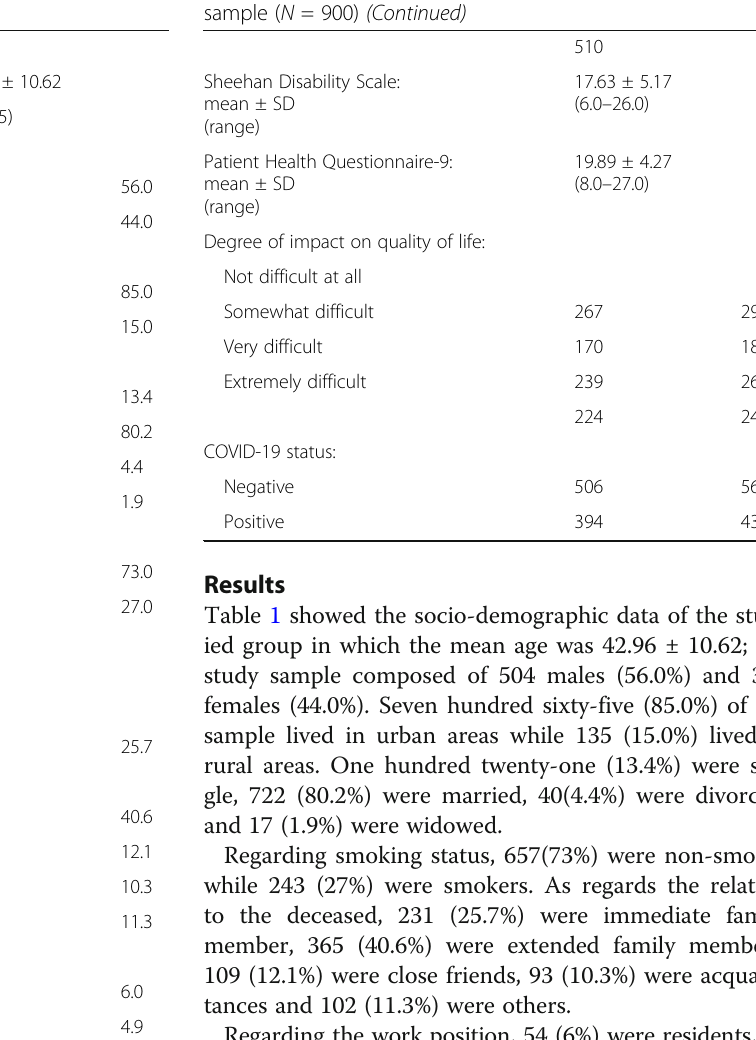
Table 1 Socio-demographic characteristics of the studied